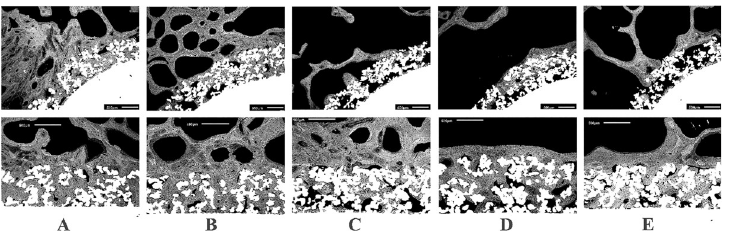
Fig 3. Representative BSE photomicrographs showing bone ingrowth into the porous-coated region of the five animals (X50 original magnification). In cross-sections of Animals A, B, and C, bone ingrowth is pronounced and mineralized. In cross-sections of Animals D and E, while there is bone ingrowth, there is also evidence of periprosthetic resorption, which is likely due to adaptation of stress shielded bone. Scale bar = 500 μ m. Porous coating; gray = bone; black = soft tissues, marrow, and cellular